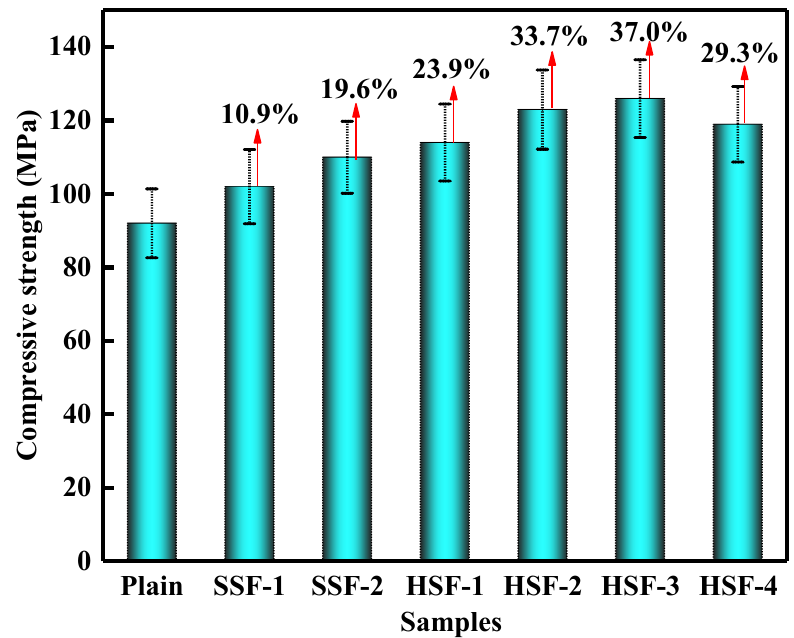
Figure 2. Compressive strength of FRC.